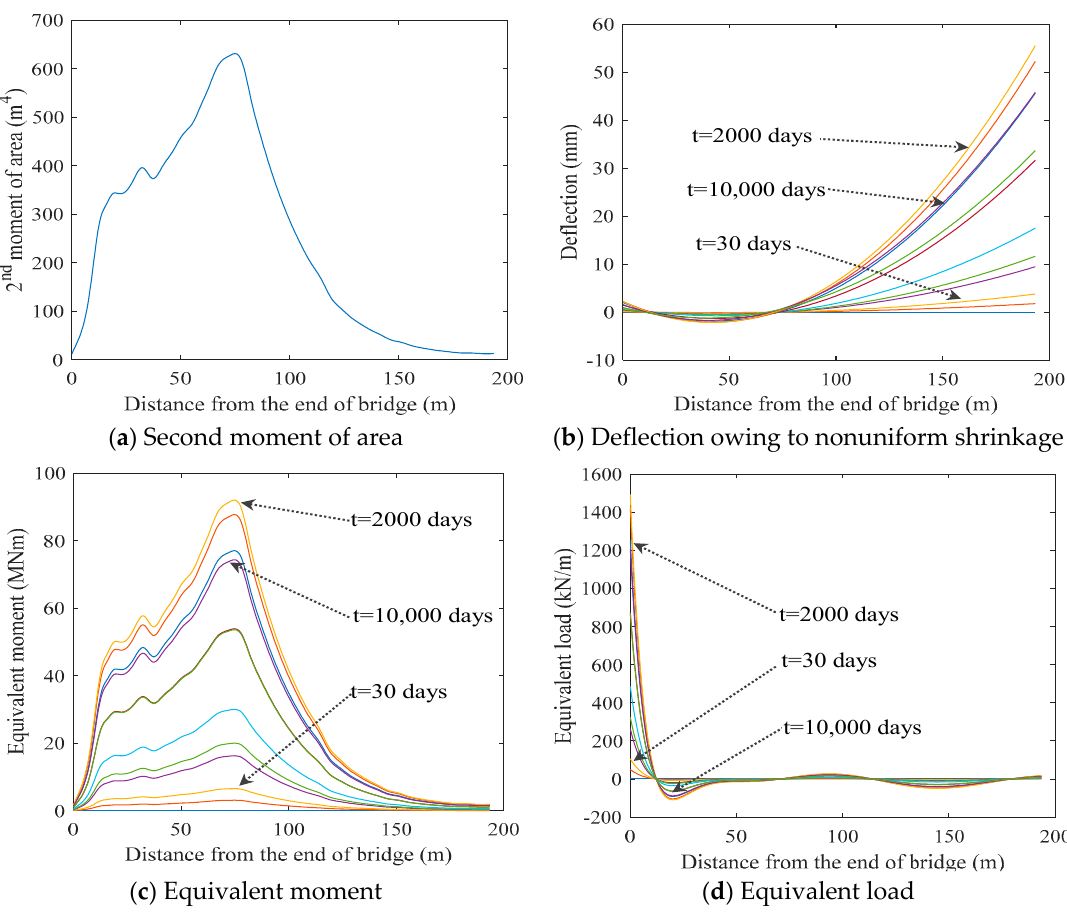
Figure 19. Variation of 2nd moment of area, deflection owing to nonuniform shrinkage, and equivalent moment and load along the span of Koror–Babeldaob Bridge.